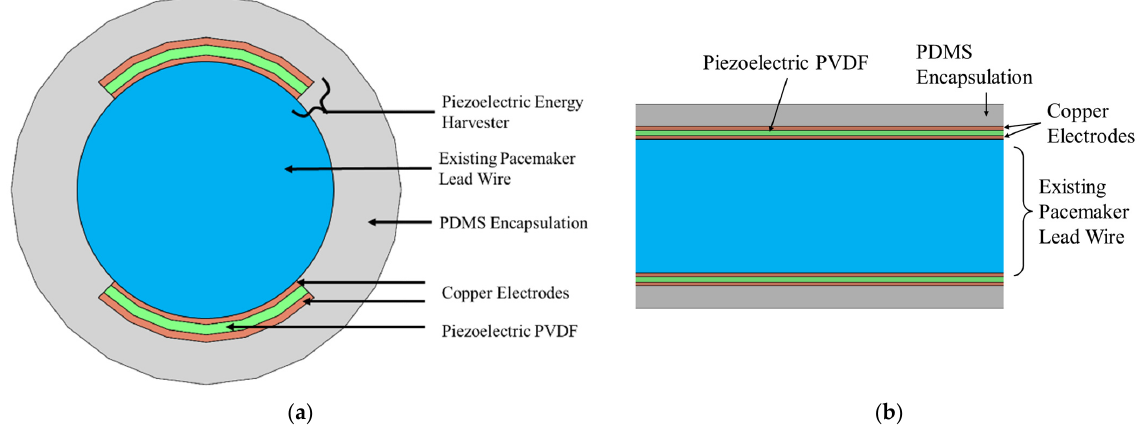
Figure 3. Schematic of proposed piezoelectric energy harvester integrated in a pacemaker lead wire. ( a ) Cross sectional view. ( b ) Longitudinal cross-sectional view. ( a ) Cross sectional view. ( b ) Longitudinal cross-sectional